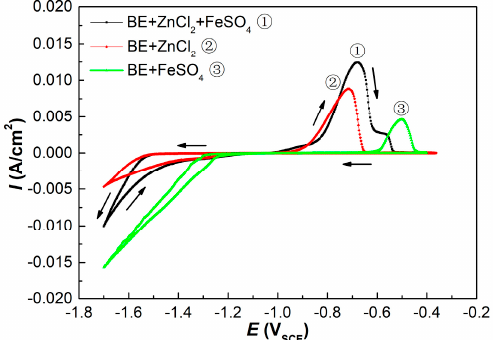
Figure 5. Cyclic voltammograms of different electrodeposition process ( ① BE + ZnCl 2 (60 g/L) + FeSO 4 (10 g/L); ② BE + ZnCl 2 (60 g/L); ③ BE + FeSO 4 (10 g/L). The working electrode of the CV test was a copper electrode).